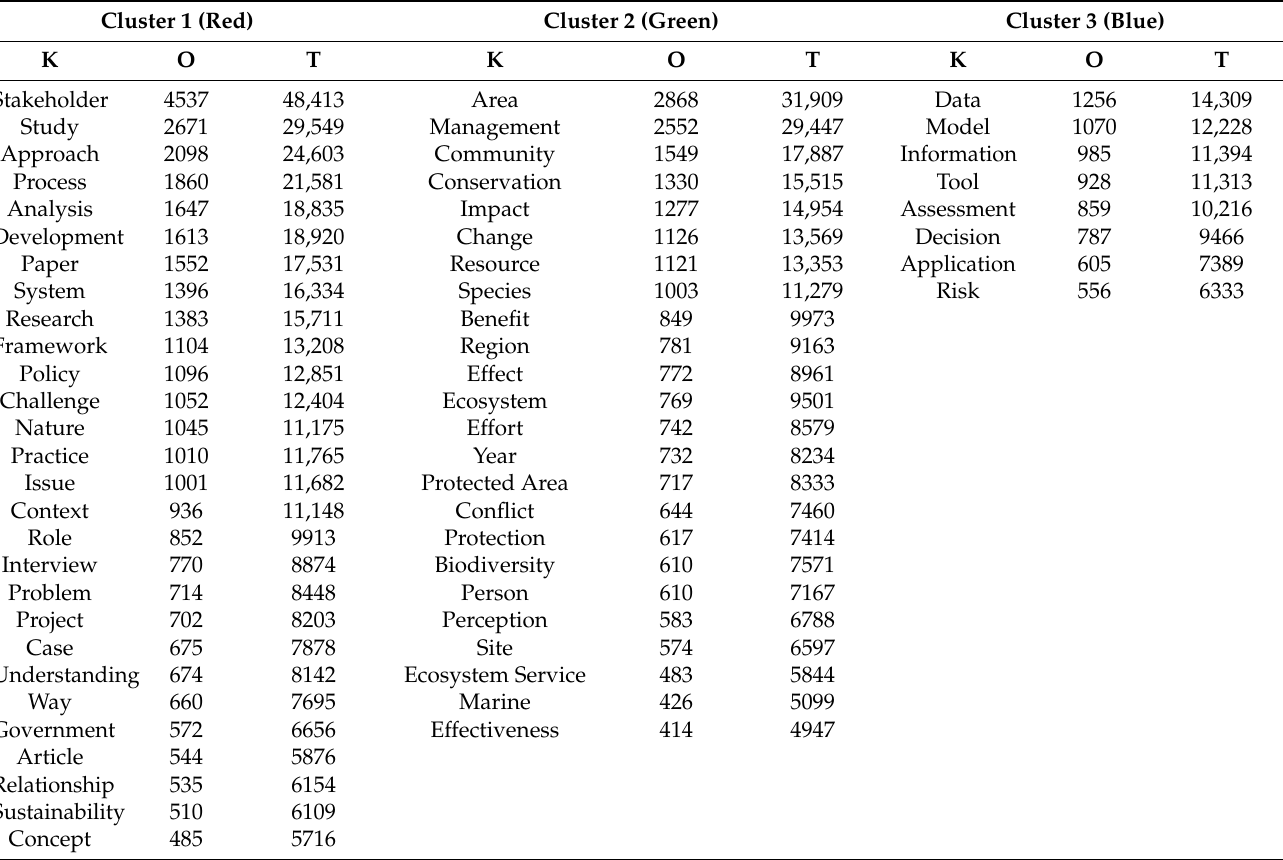
Table 1. Clusters and relative keywords resulting from the co-occurrence analysis of